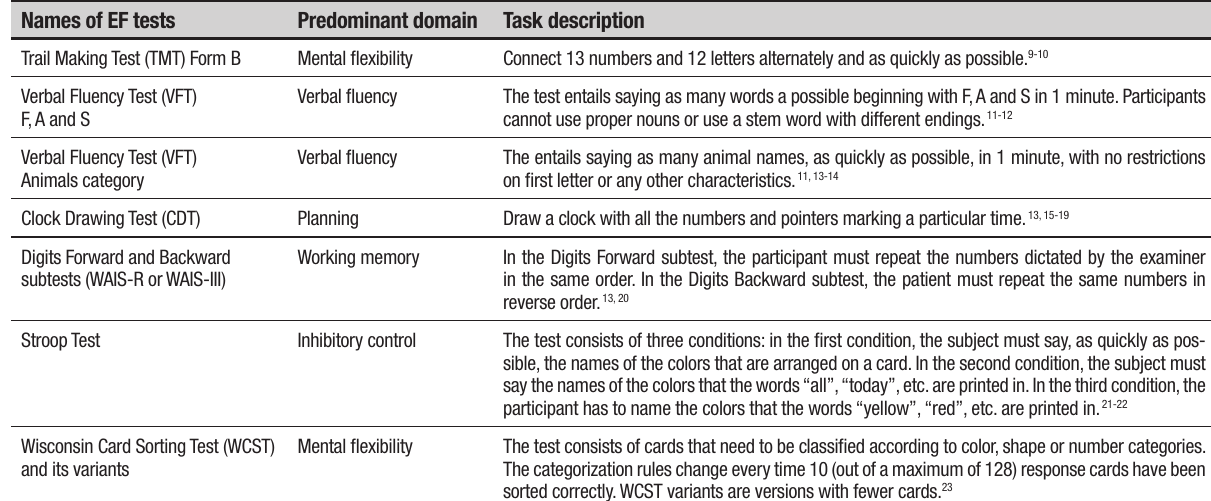
Table 1. The seven executive function tests most frequently used in aging research. Names of EF